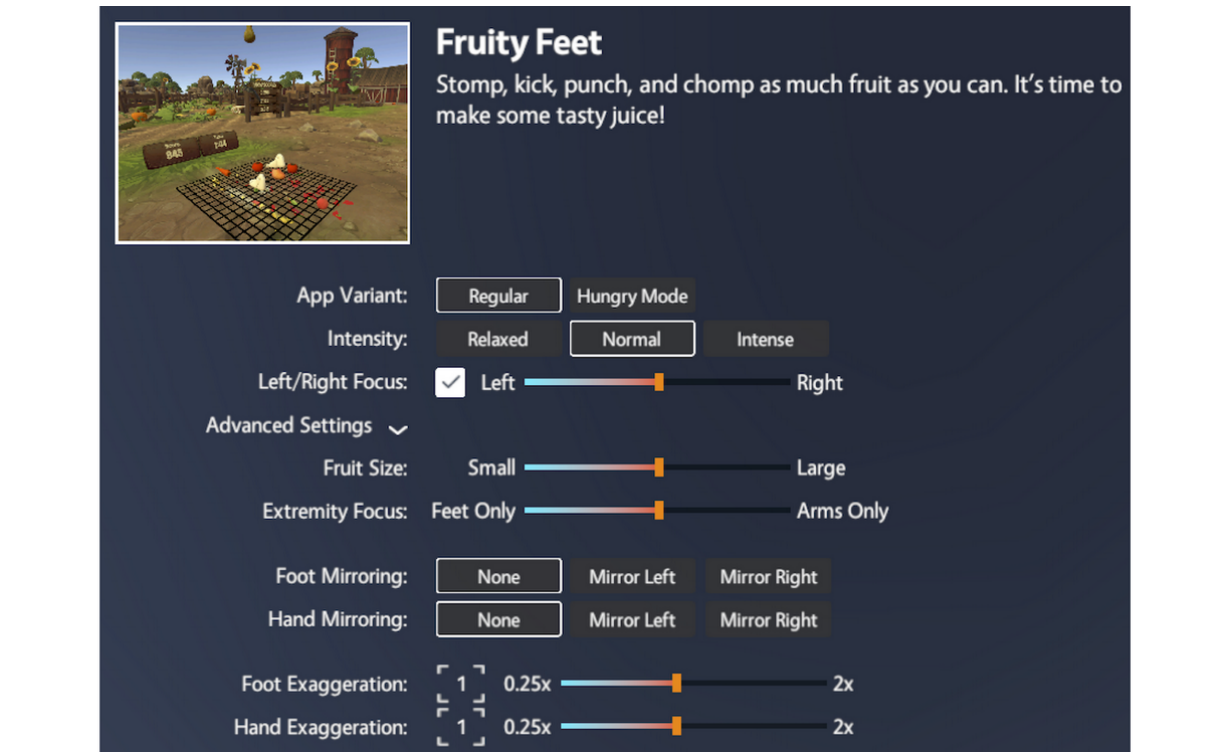
Figure 4. Fruity Feet control panel. Using the control panel, clinicians can adjust the game to better fit the needs of their patient. Intensity affects the rate at which fruit appears in the world. Left/Right Focus focuses the game activity on the left/right side of the patient, encouraging patients to use their affected side. Fruit Size changes how high players must lift their foot in order to effectively stomp a fruit. Extremity Focus focuses the game activity on the player’s lower or upper extremities. Foot/Hand Mirroring enables an experimental mode that mirrors the virtual extremity, much like mirror therapy. Foot/Hand Exaggeration enables an experimental mode that affects the movement gain of the virtual avatar's feet and hands (higher exaggeration results in the virtual avatar moving farther than the patient moved in the real world, and lower exaggeration results in the virtual avatar moving less than the patient moved in the real